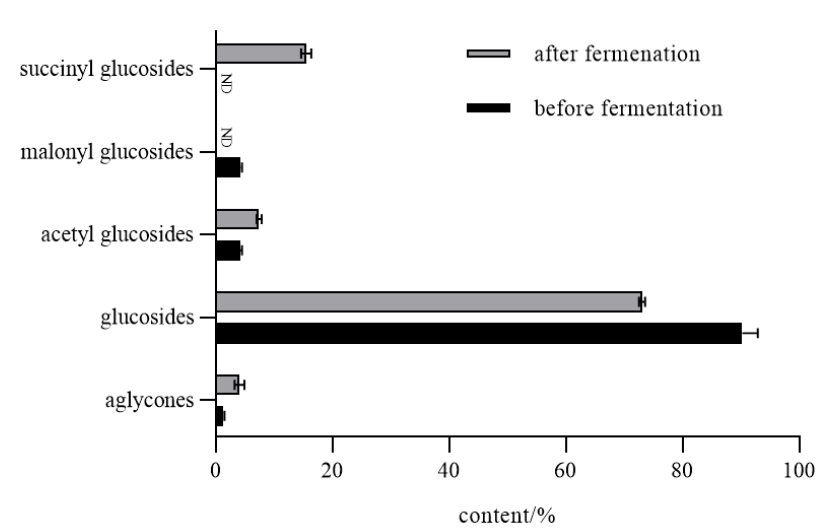
Figure 2. Changes in flavone content before and after fermentation. ND means not